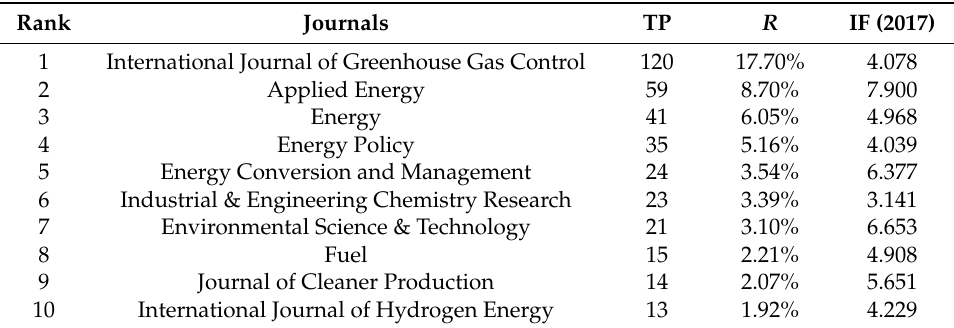
Table 2. Top 10 productive